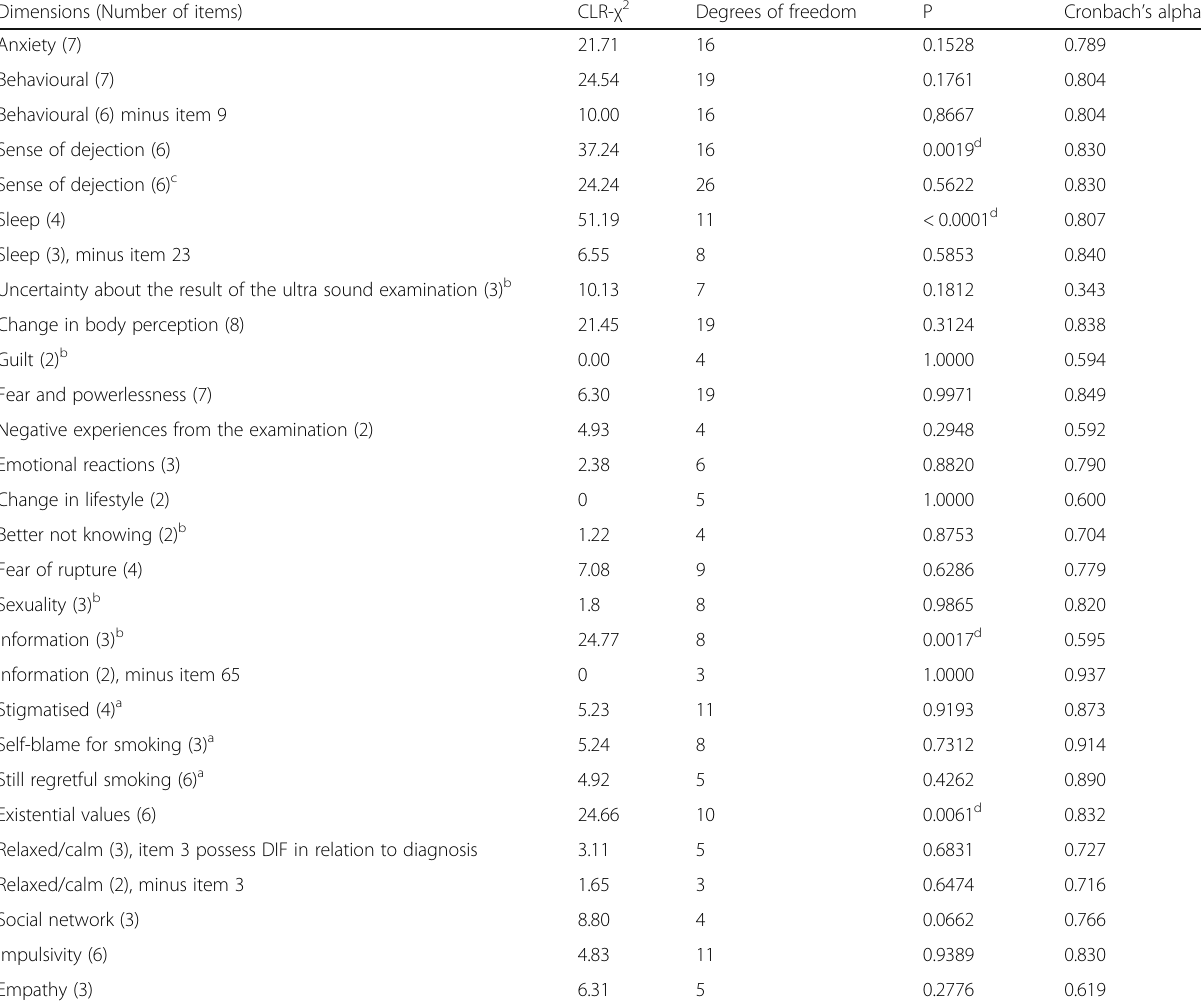
Table 2 Fit statistics and reliability (Cronbach ’ s alpha) of the dimensions of the COS-AAA Dimensions (Number of